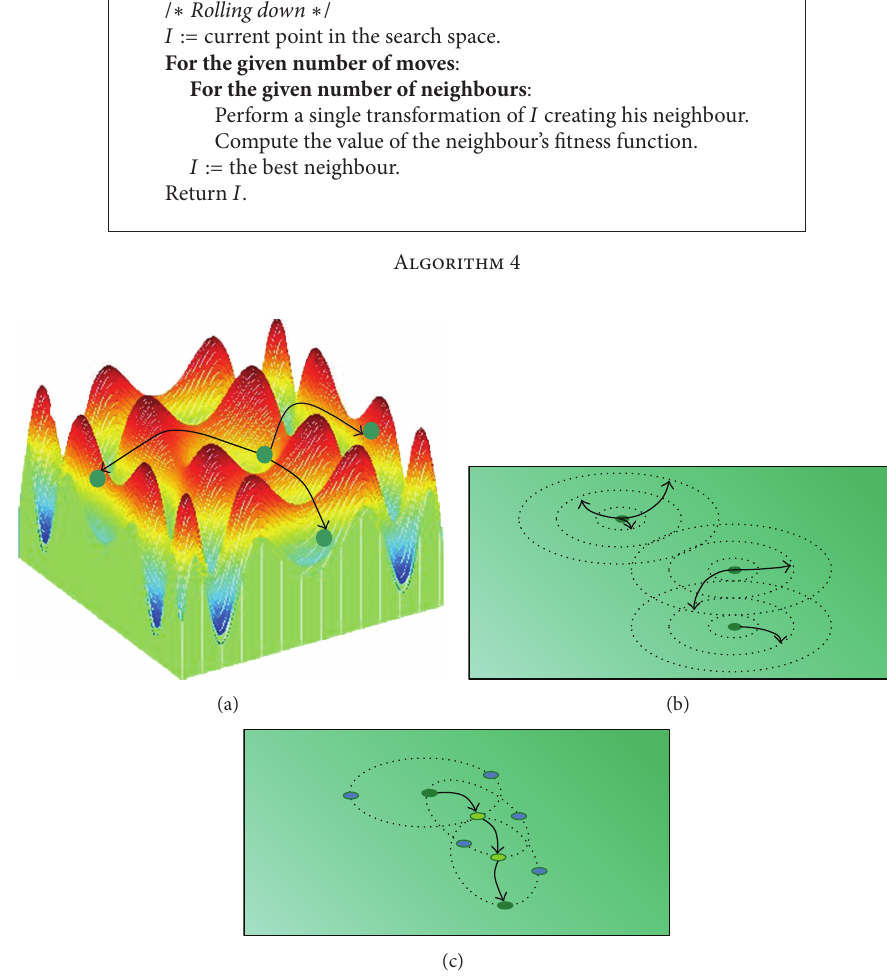
Figure 2: Idea of (a) spreading, (b) dispersing, (c) rolling down ( 𝑘 = 3